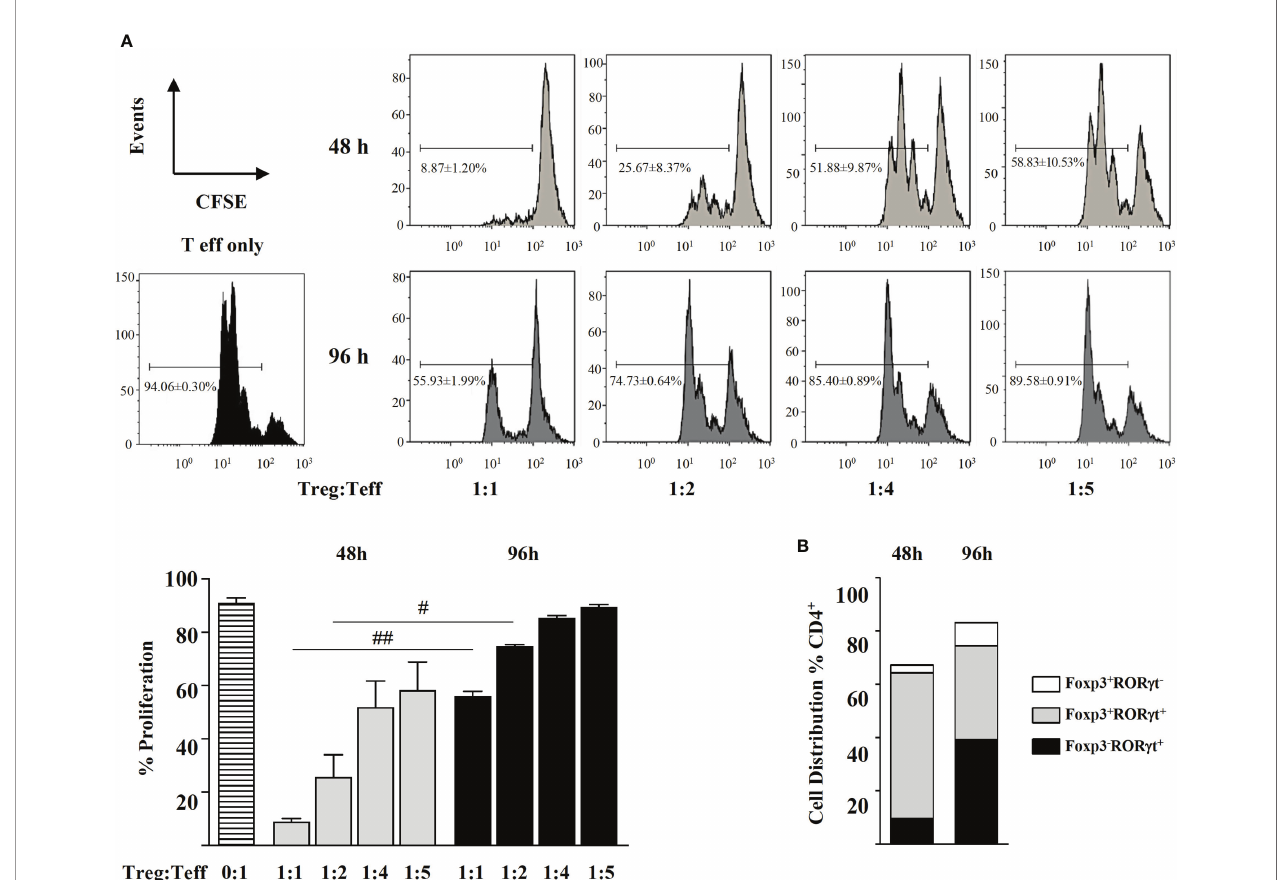
FIGURE 4 | Magnetic sorted naïve CD4 + CD44 - CD62L + spleen cells from BALB/c mice were stimulated with plate-bound anti-CD3 and soluble anti-CD28 in the presence of IL-2 (20 ng mL -1 ), TGF- b (5 ng mL -1 ), and RA (0.1 m M) for 48 and 96 h. (A) Suppressive activity of the cells thus generated (Treg) in co-cultures with different ratios of CFSE-labelled CD4 + effector T cells (Teff) in the presence of anti-CD3- and anti-CD28-coated latex beads for 72h. (B) Distribution of the generated Foxp3 + ROR g t - , Foxp3 + ROR g t + , and Foxp3 - ROR g t + T cells after 48 and 96 h of culture. Data are means of three different experiments (each performed with cells sorted from polled spleens from 5 mice) ± SEM (n = 3). # P < 0.05, ## P < 0.01 indicate statistically signi fi cant differences between time points for each culture condition assessed by the unpaired two-tailed Student ’ s t